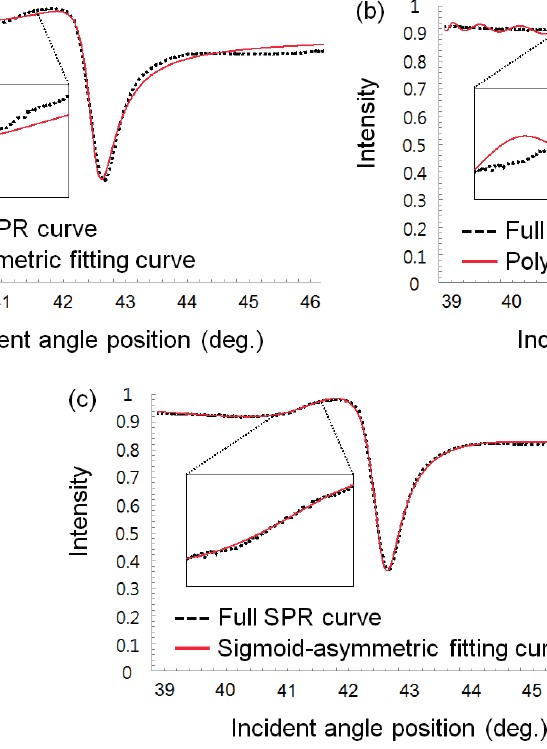
Figure 6. SPR curve-fitting results measured in air (black dot line: SPR curve, red solid line: fitting curve): ( a ) Asymmetric fitted SPR curve. ( b ) 24th-order polynomial regression-fitted SPR curve. ( c ) Sigmoid-asymmetric fitted SPR